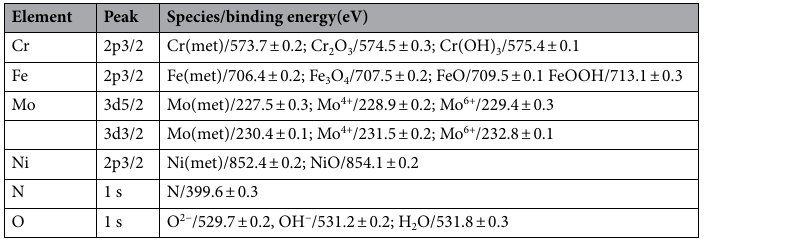
Element Peak Species/binding